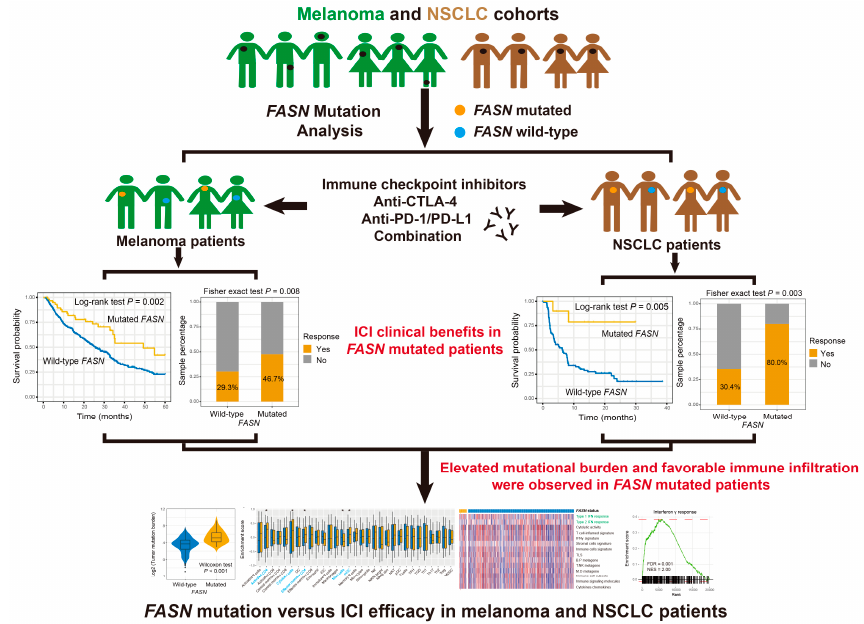
Figure 1. Flowchart of this study. Association of FASN mutations with ICI efficacy in melanoma and